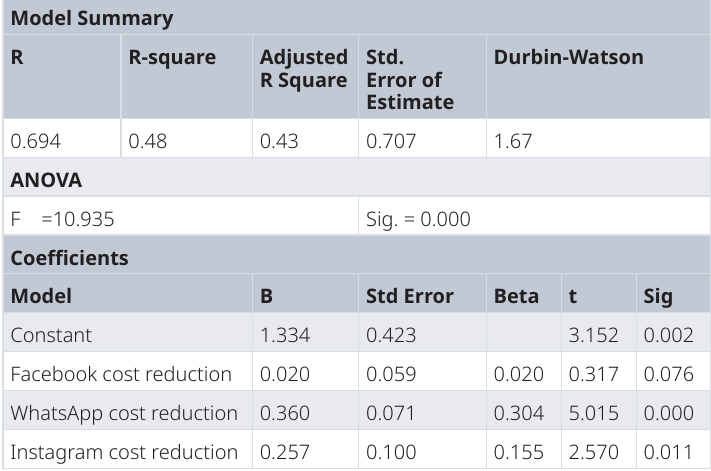
Table 4. Usage of social media and cost of marketing agricultural